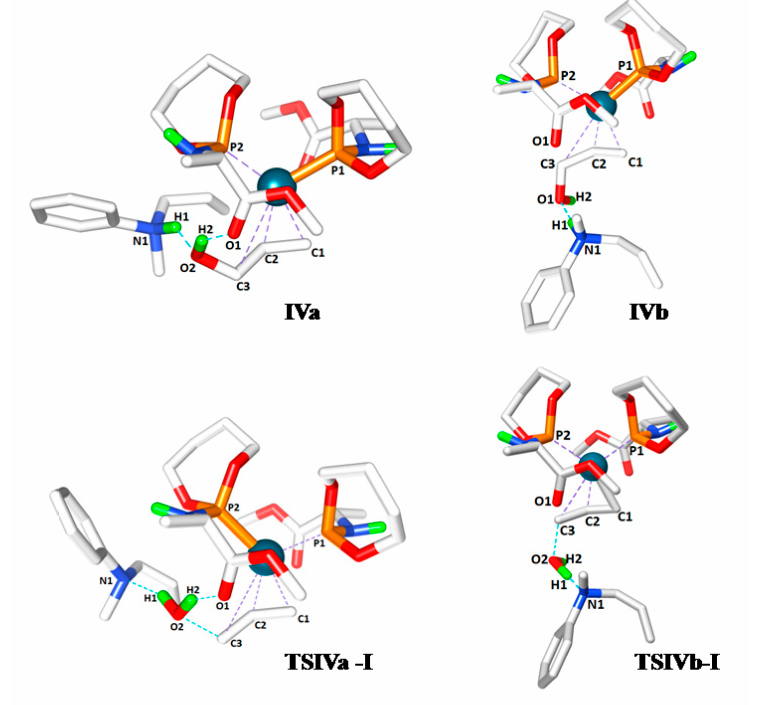
Figure 2. Transition state structures of IVa , TSIVa-I , IVb and TSIVb-I